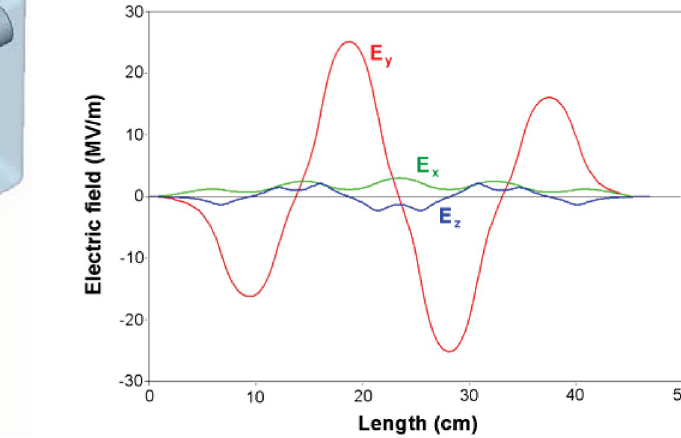
FIG. 3. (Color) 3D view of the rf deflector.